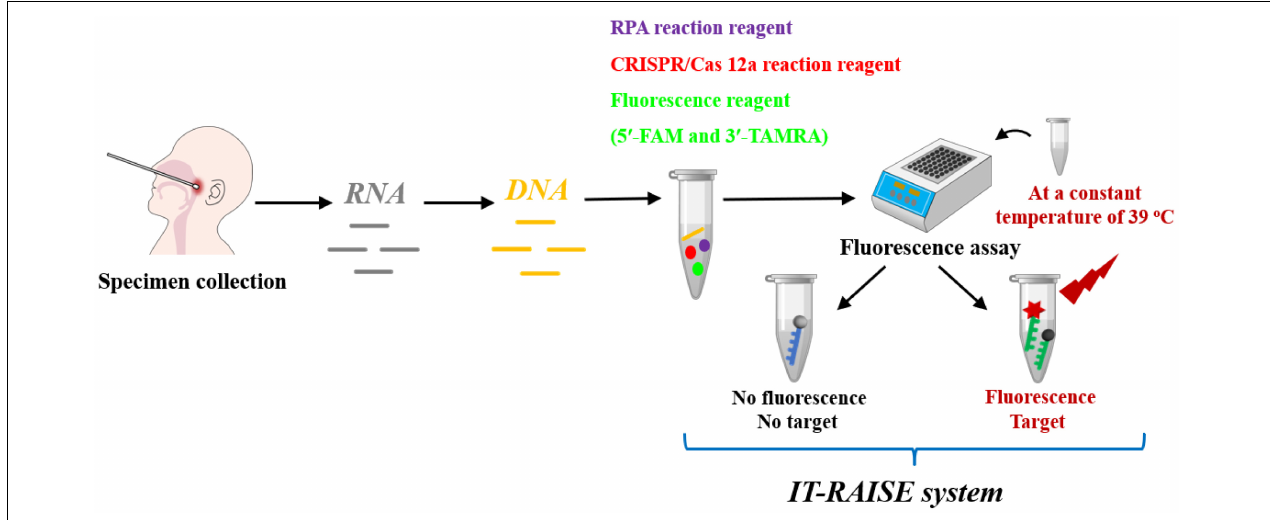
FIGURE 1 | The working principles of the IT-RAISE system for RSV A or RSV B detection. If RSV A or RSV B is present, Cas12a cleaves RSV A or RSV B RPA products and a fluorescent single-stranded DNA (ssDNA) reporter (5 (cid:48) -FAM and 3 (cid:48) -TAMRA). Fluorescence quenching is terminated and fluorescence appears. If RSV A or RSV B sequences are not present, fluorescence quenching occurs and no fluorescence